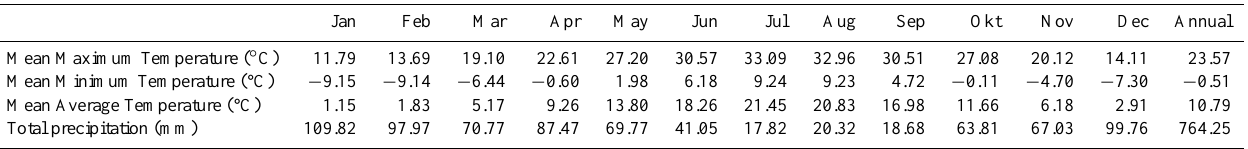
Table 2. A summery of modern-day climatic conditions in the study area as collected by the weather station in A˘glasun (37 ◦ 39 0 N 30 ◦ 32 0 E). The data presents average values of data collected between 1972 and 1992 (Aðlasun Meteorology Station. Turkish State Meteorological Service, Ankara).